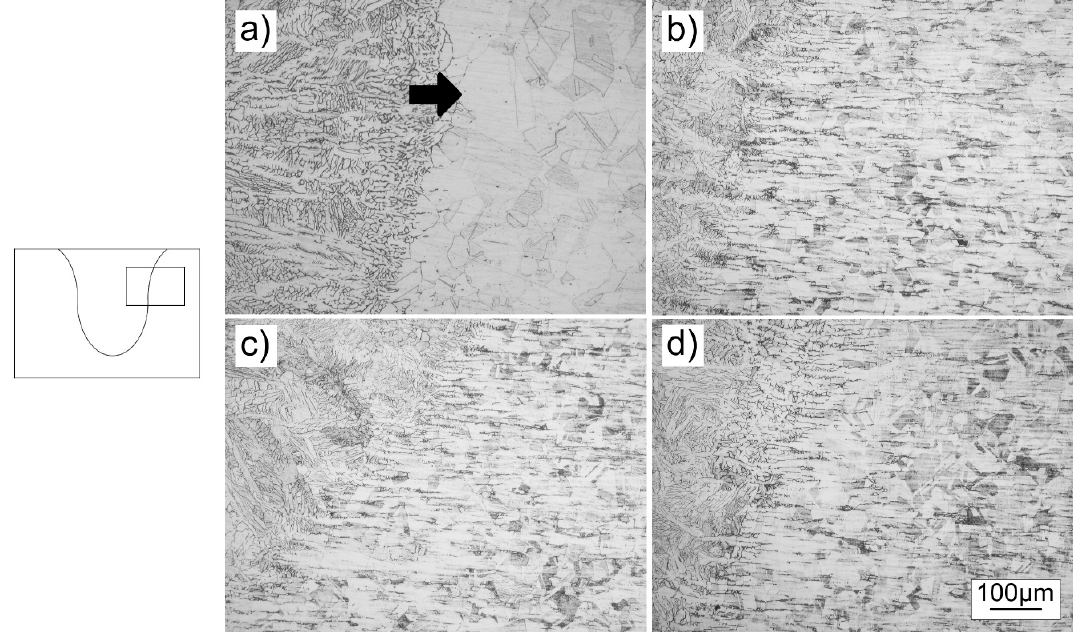
Figure 4. Microstructures under the surface of the specimen near the melt line: ( a ) specimen 0; ( b ) specimen 5Ti; ( c ) specimen 1Si4Ti; ( d ) specimen 2Si3Ti.